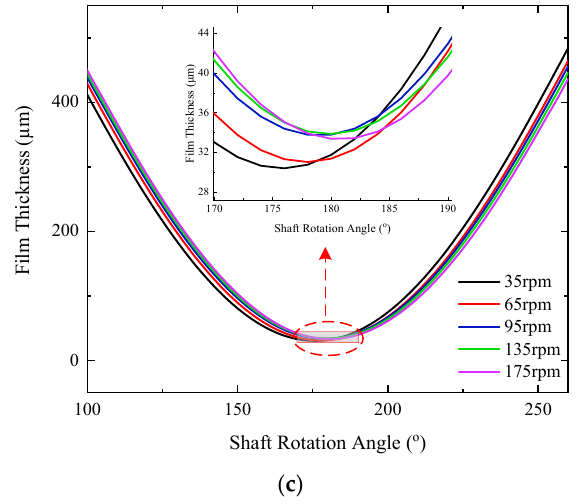
Figure 9. Film thickness ‐ circumference distribution of test sections at different rotational speeds: ( a ) D 1 section; ( b ) D 2 section; and ( c ) D 3 section.